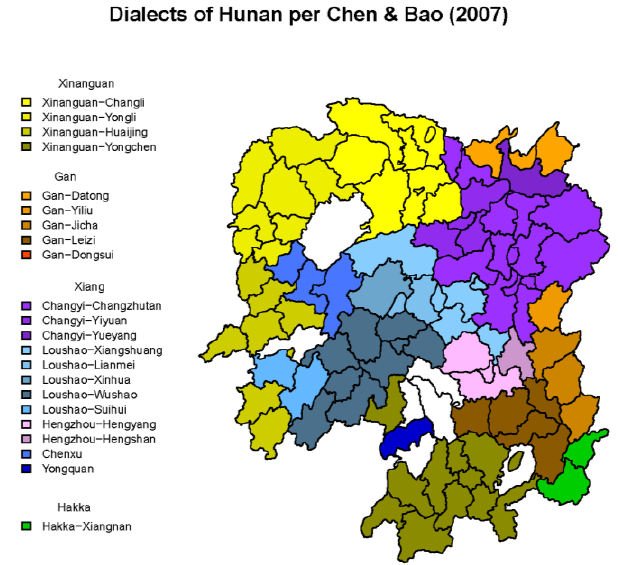
Figure 1. Classification of Xiang varieties (shades of blue = Loushao, Chenxu, Yongquan; purple = Changyi; pink = Hengzhou), following Chen and Bao (2007).